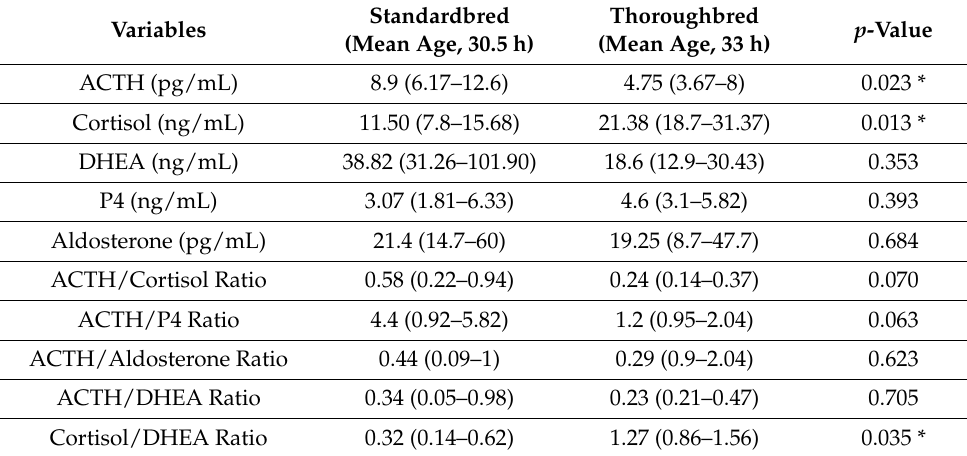
Table 2. Plasma hormone concentration and ratios expressed as the median and range in